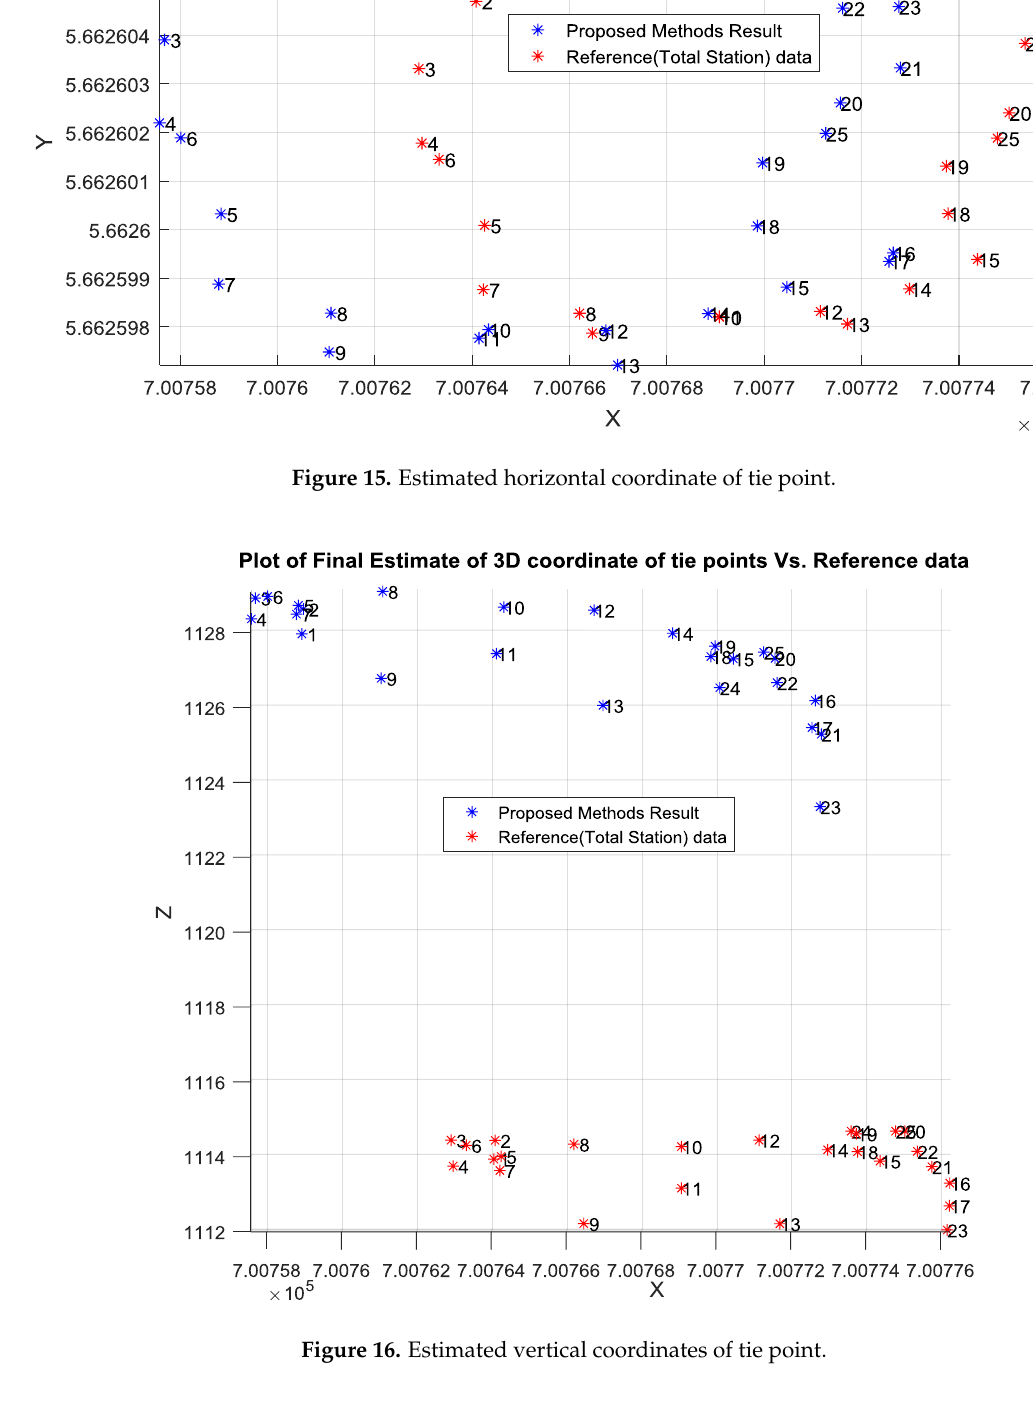
Figure 16. Estimated vertical coordinates of tie point.